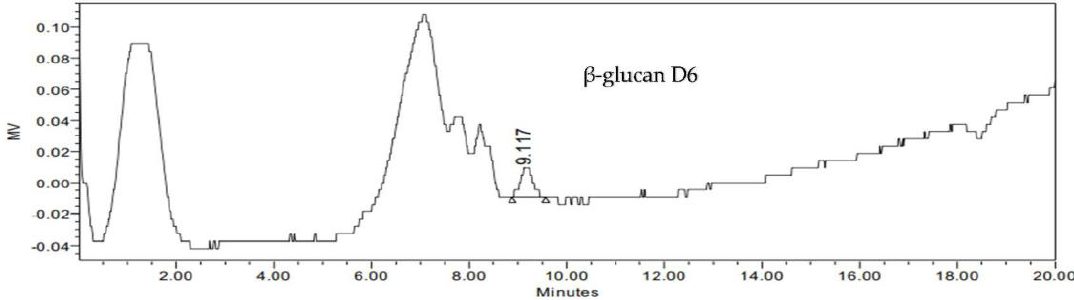
Figure 6. HPLC analysis of the β -glucan composition of A3, B6, C9, D6 isolates as well as standard (β -glucan) and control strain (LGG) .